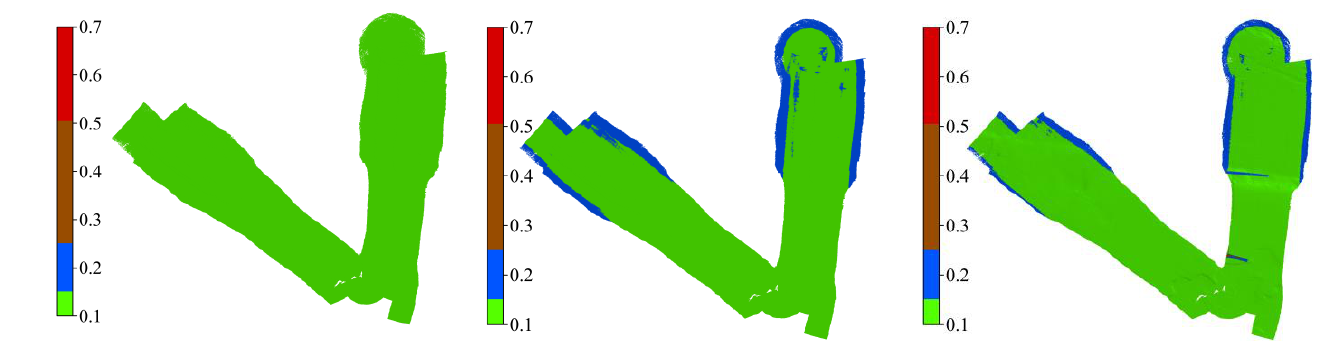
Figure 9. Ordered left to right : shows the bathymetric surfaces at 0.25-m resolution for POSMV (Wave-Master), the difference map for POSMV versus Ellipse-D, and the difference map for POSMV versus FOG 3-D.